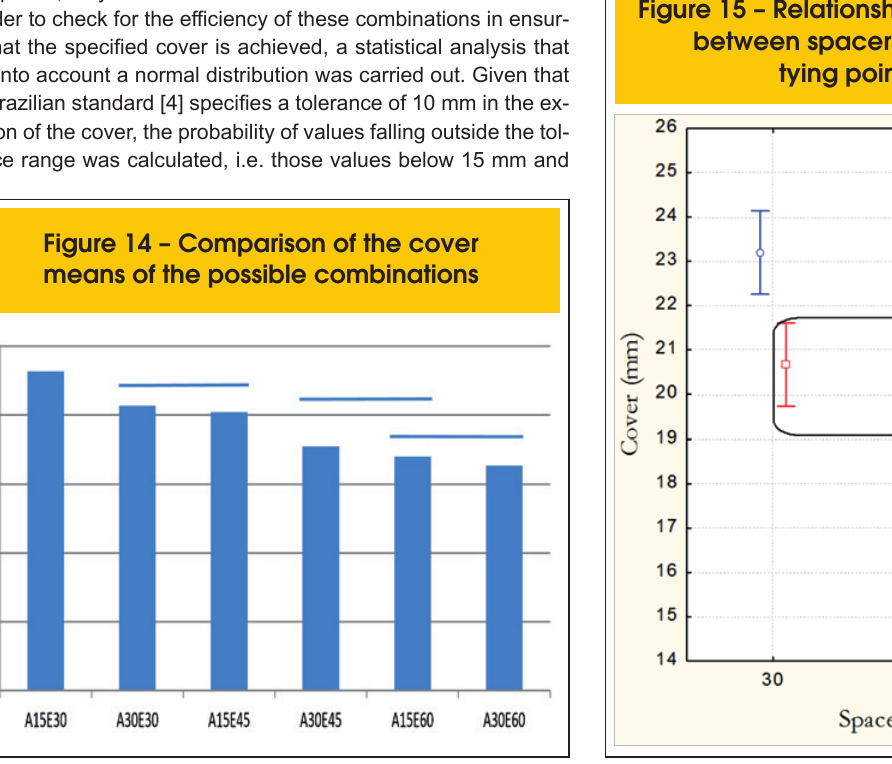
Figure 15 – Relationship between the distance between spacers, distance between tying points and